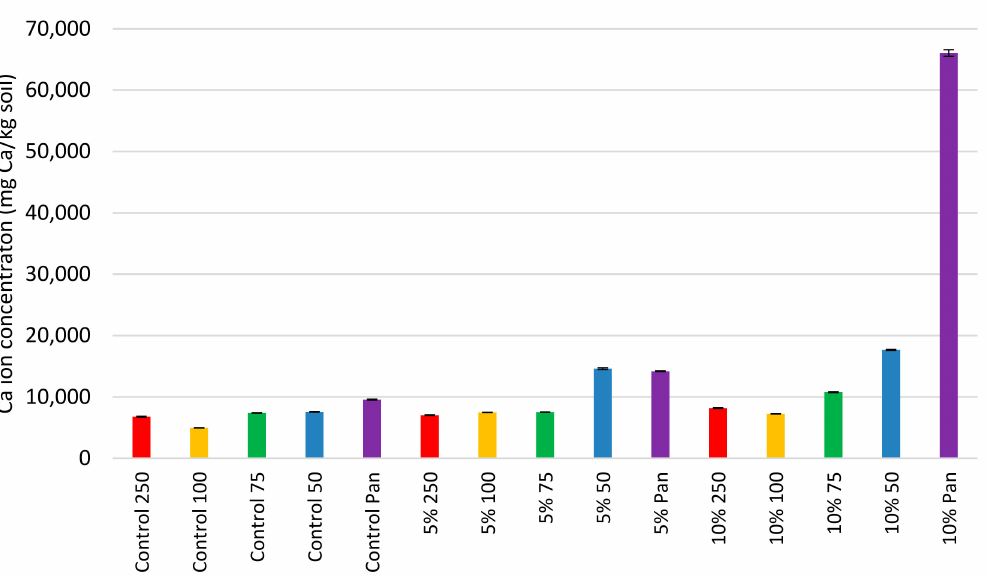
Figure 4. Calcium concentration in the samples obtained from fractionated control, 5 wt.% RFT, and 10 wt.% RFT soils, determined by ICP-MS after acid digestion. Error bars represent the replicate measurement (five) relative standard